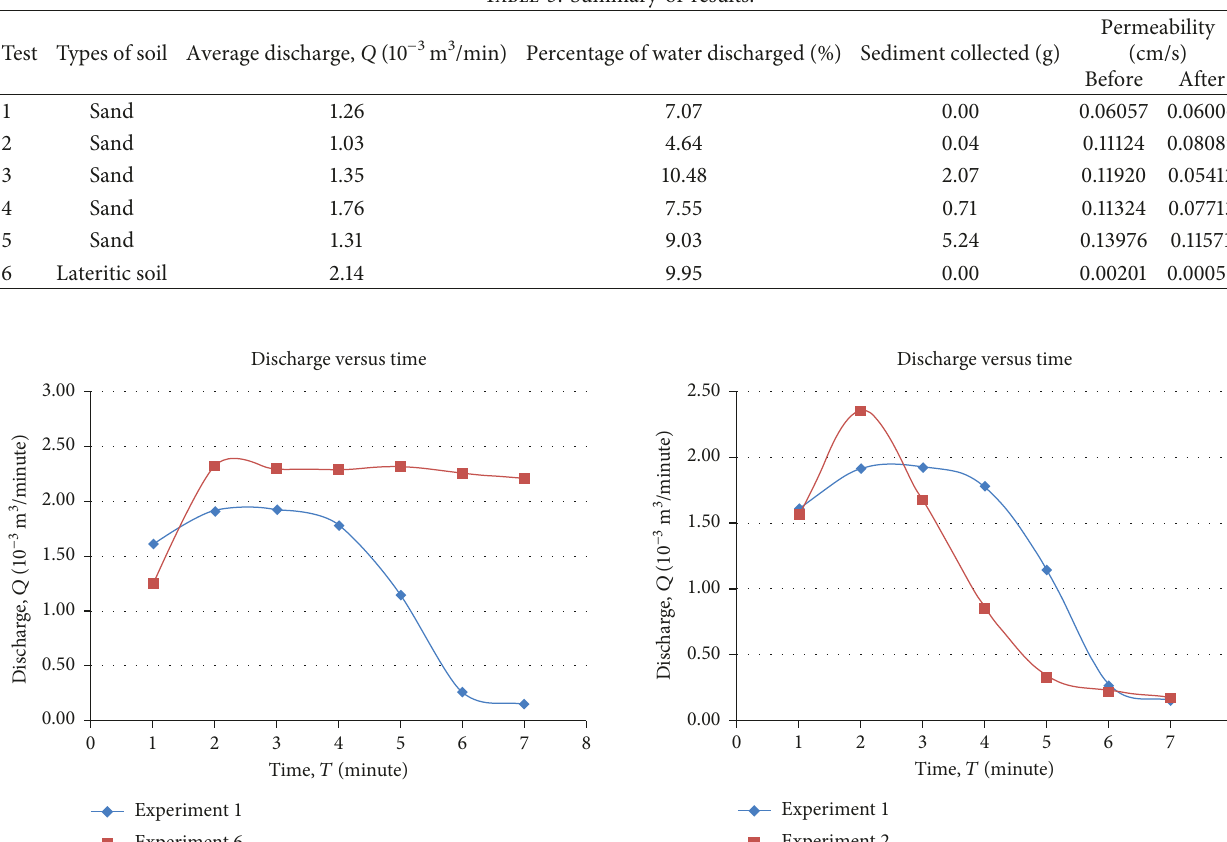
Table 5: Summary of results.